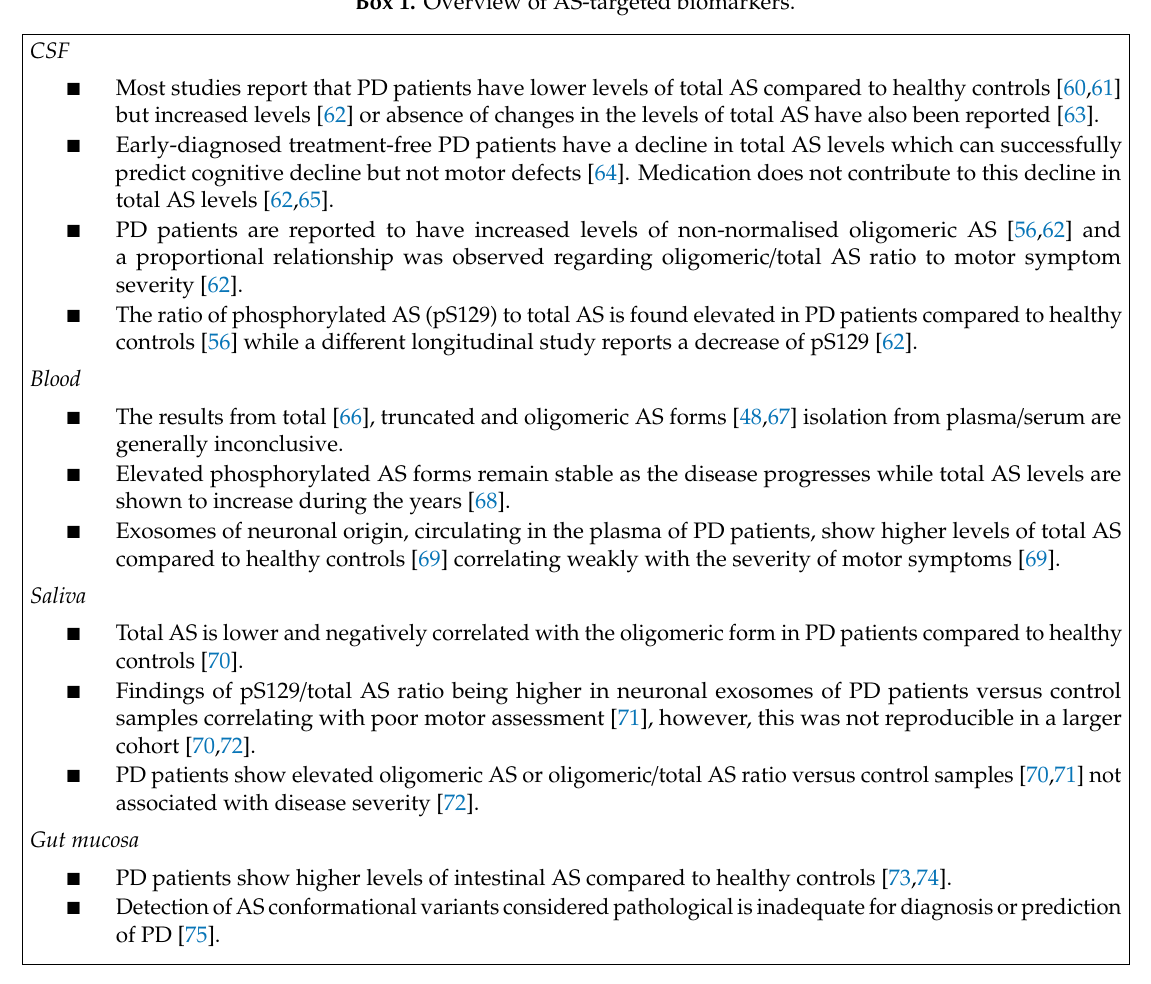
Box 1. Overview of AS-targeted